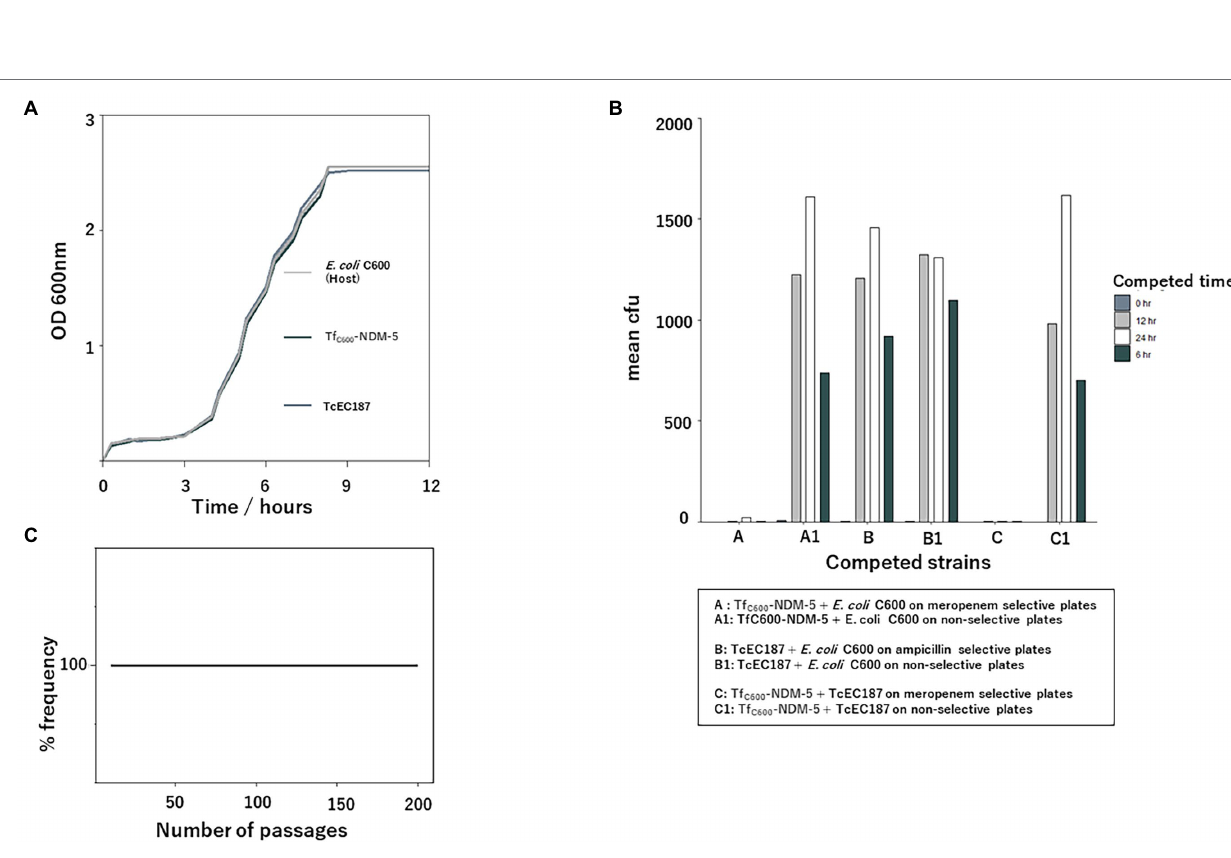
FIGURE 5 | Stability, growth kinetic, and competition analyses of IncX3- bla NDM-5 -containing plasmid. (A) Growth curve comparison of Escherichia coli C600, its transformant with the IncX3- bla NDM-5 plasmid, and transconjugant with the IncX3- bla oxa-181 plasmid. (B) Competition analysis between E. coli C600 with its transformant and transconjugant, as well as between the transformant and the transconjugant. (C) Stability analysis of IncX3- bla NDM-5 -containing plasmid. The IncX3- bla NDM-5 plasmid persisted in E. coli Top10 after successive passaging on antibiotic-free media (12 h passage, twice daily for 100 consecutive days (200 passages) corresponding to approximately 2,400 generations of E. coli Top